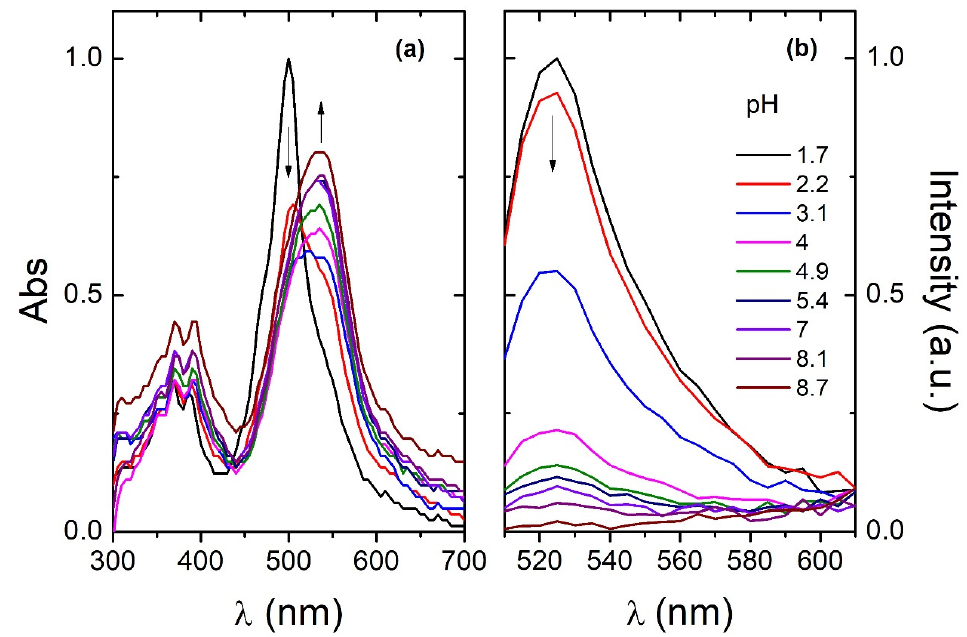
Figure 3. ( a ) Absorption and ( b ) fluorescence spectral changes of BODIPY 3 under different pH conditions (pH = 1.7–8.7).